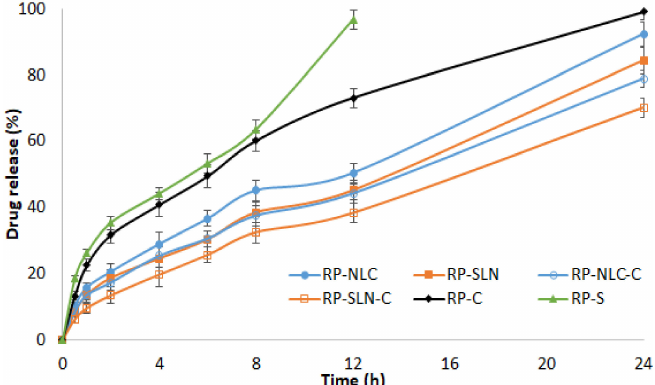
Figure 1. In vitro release profiles of RP from RP loaded lipid nanoparticles, hydrogel formulations and control formulations through the dialysis membrane (mean ± SD, n =